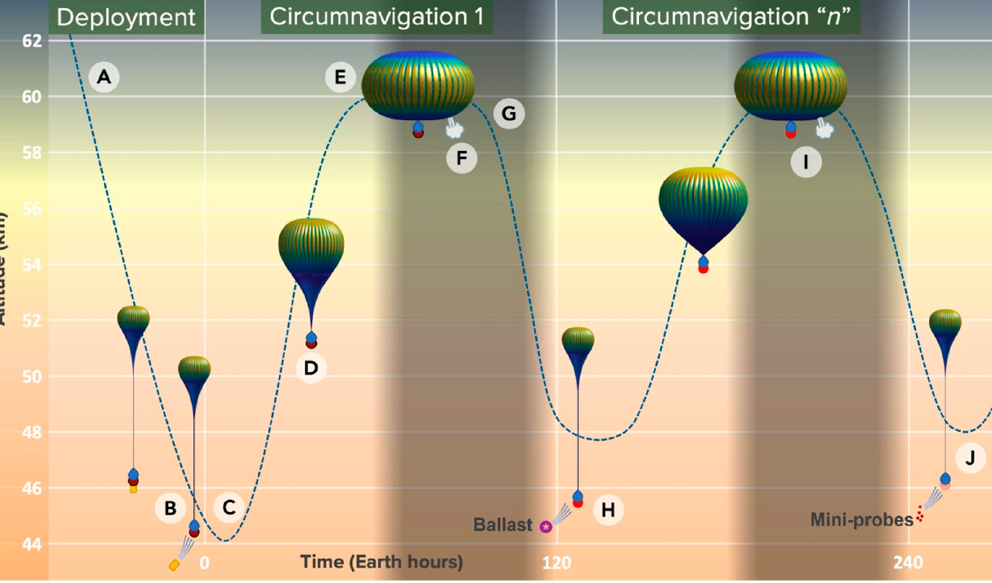
Figure 6. Variable Altitude Balloon (VAB) aerial platform conops. See the main text for description of steps A–J.